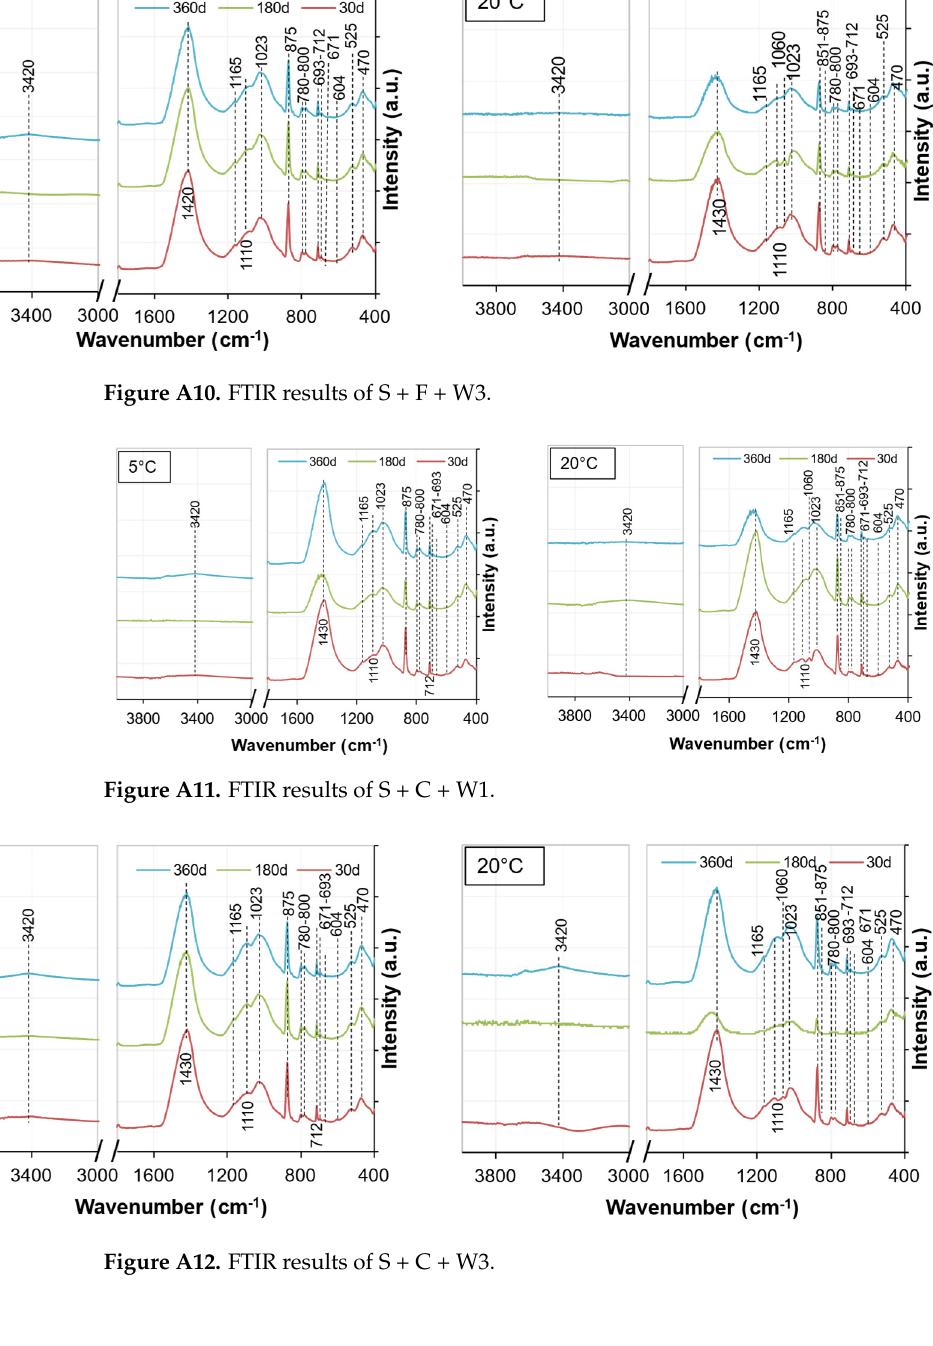
Figure A11. FTIR results of S + C + W1.